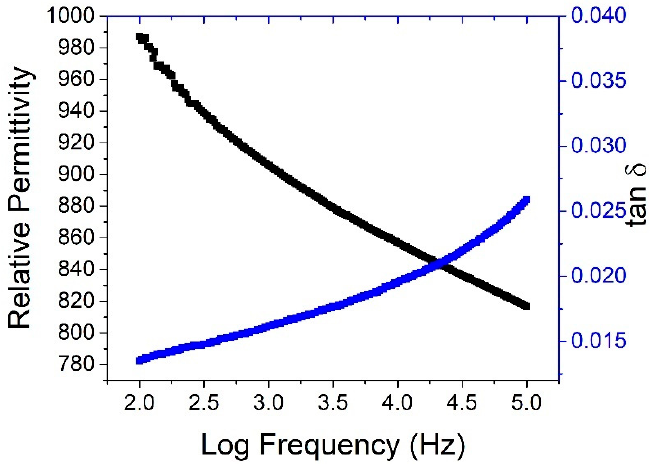
Figure 7. Relative permittivity of the 30 element PZT–polymer 2-2 composite as a function of log of frequency.